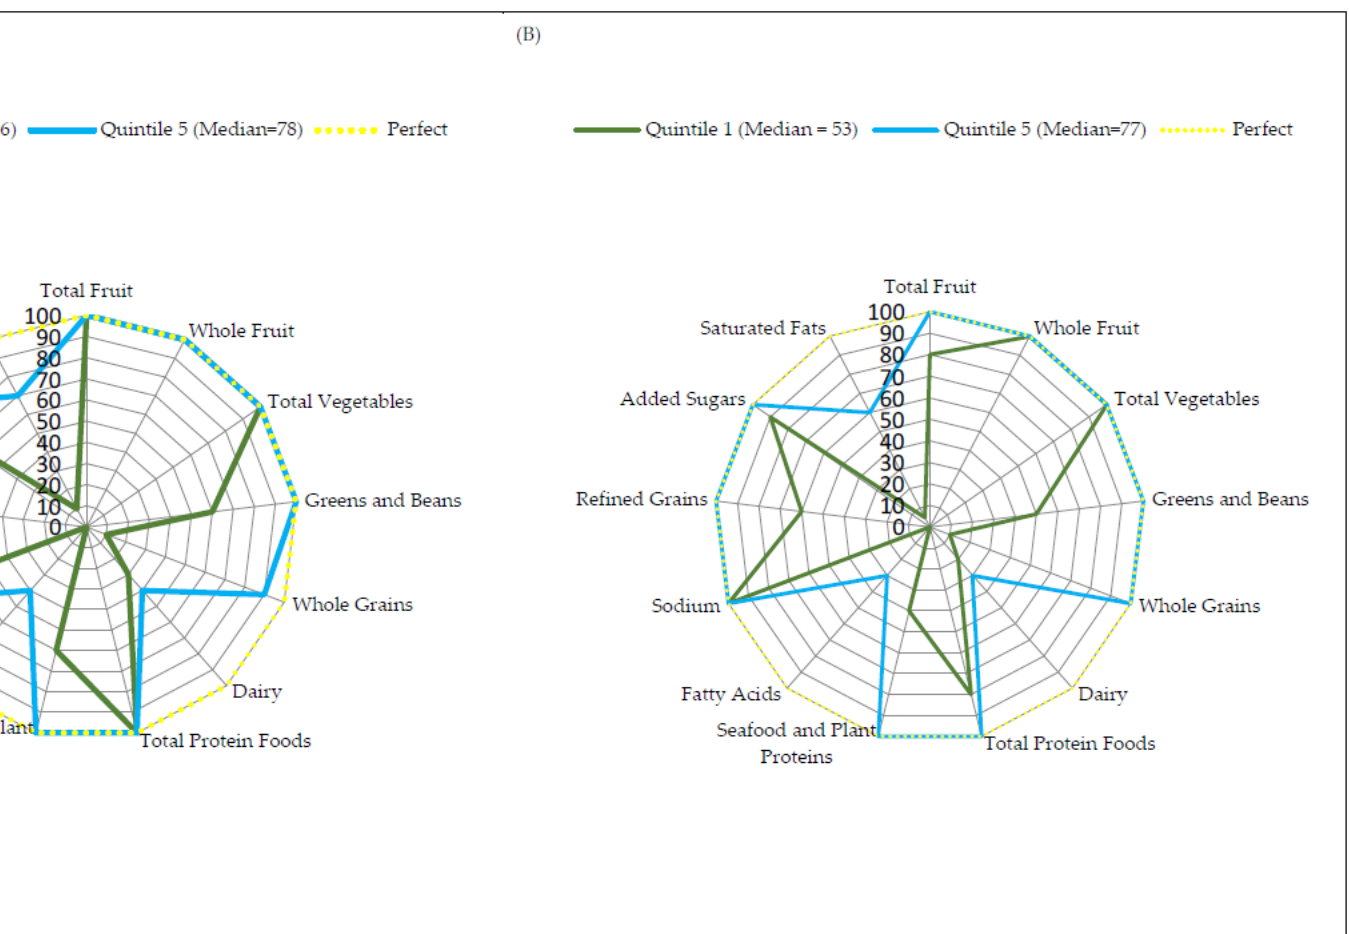
Figure 1. Radar graphs depicting a perfect score (100 points) and median component scores for ( A ) women and ( B ) men score in quintile one and quintile five for HEI-2015.